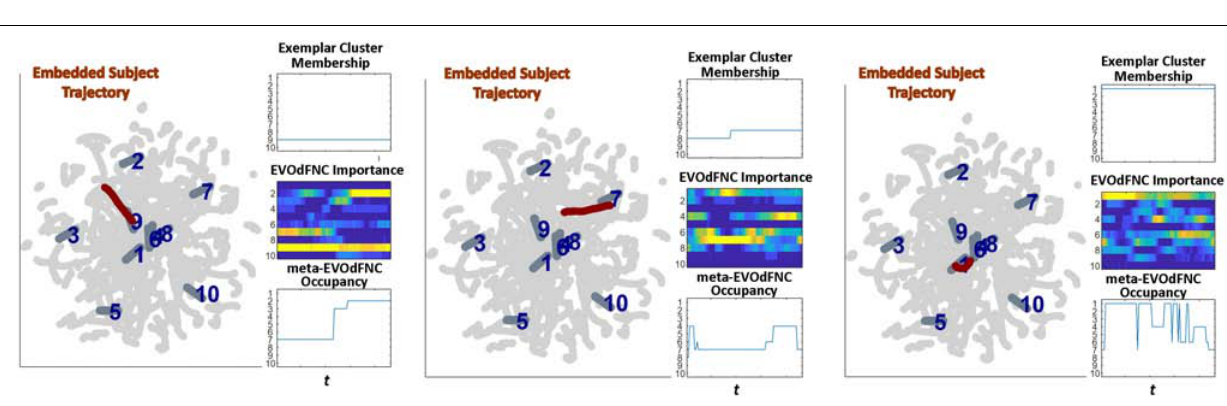
EVOdFNC 8, is significant at the p < 0 . 05 level after correction for multiple